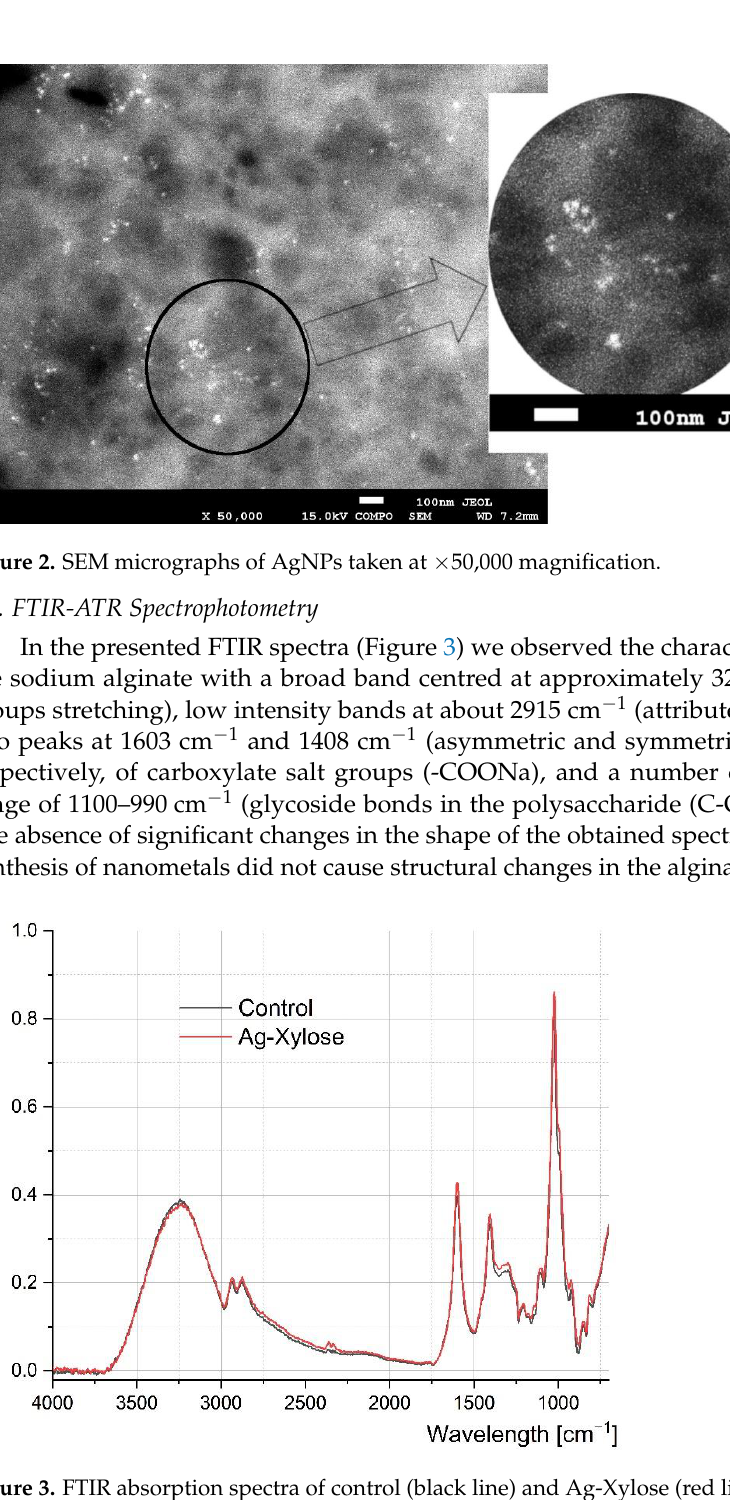
Figure 3. FTIR absorption spectra of control (black line) and Ag-Xylose (red line).